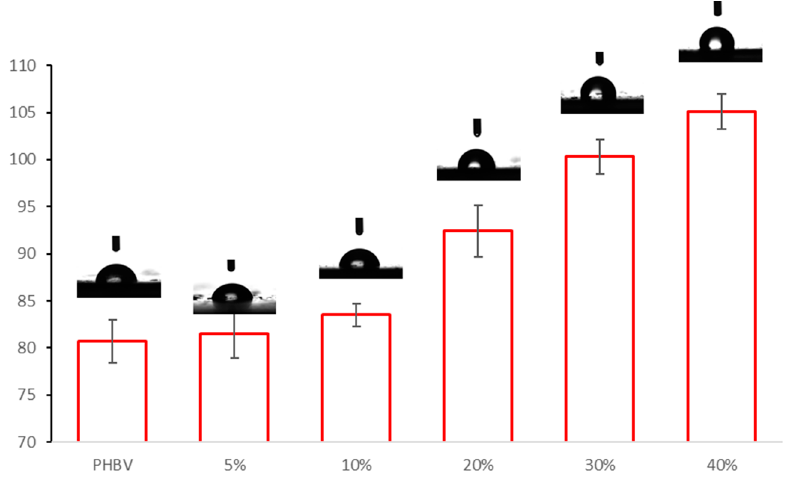
Figure 11. Water contact angle pictures for PHBV and all the bio-composites.